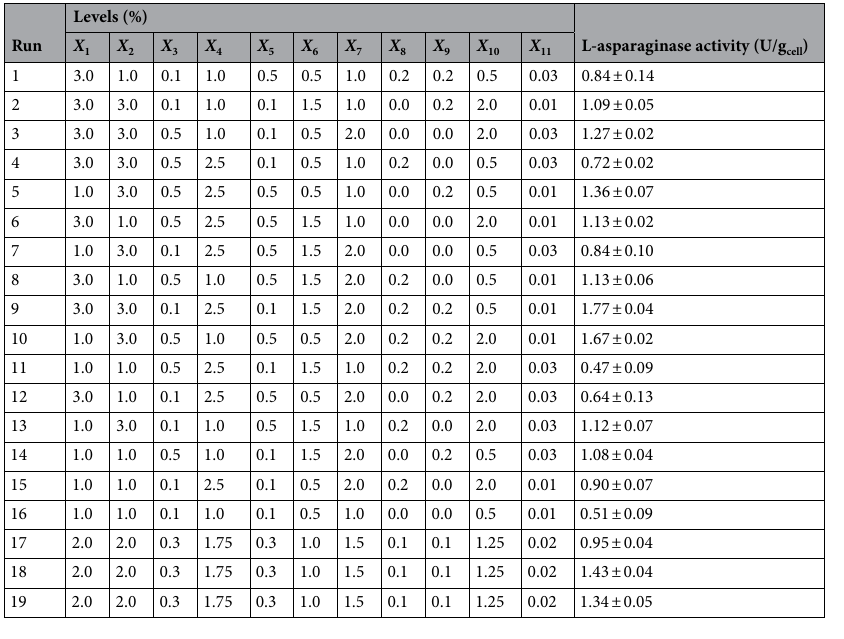
Table 1. L-asparaginase activity as Plackett–Burman experimental design for Penicillium cerradense . L-asparagine (